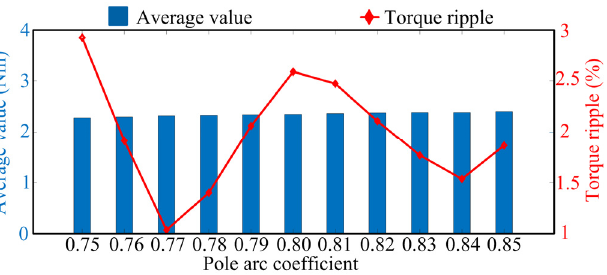
Figure 12. Effect of pole arc coefficient on electromagnetic torque in a machine with 8-pole and 27-slot.